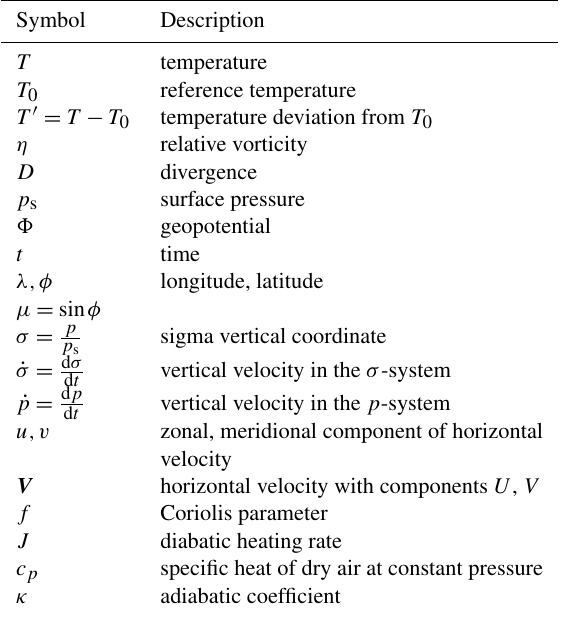
Table 1. Symbols and variables in the PUMA